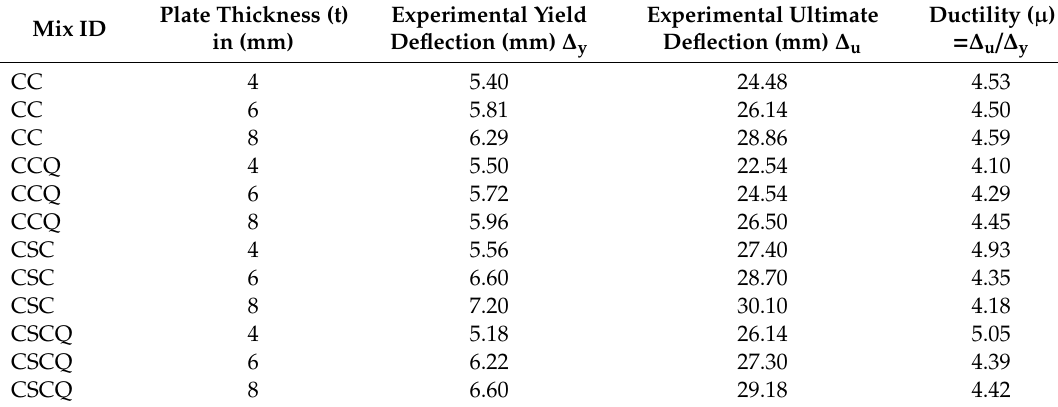
Table 6. Ductility ratio of tested